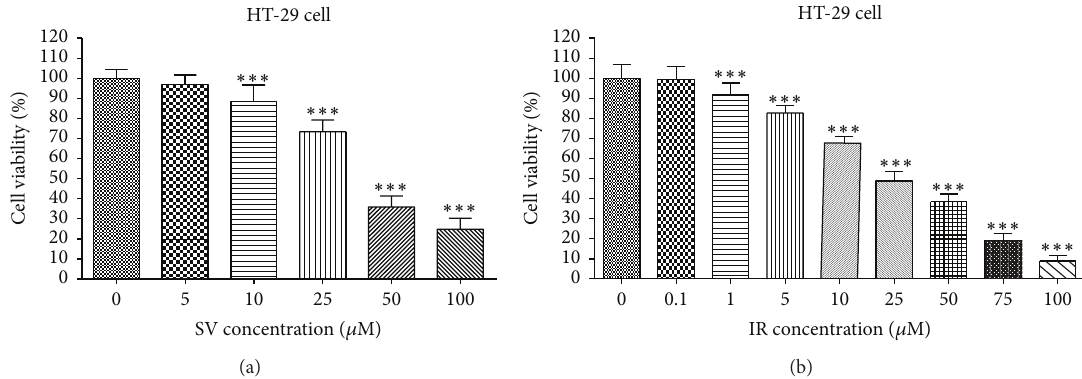
Figure 1: Effect of simvastatin or irinotecan alone on cell viability in HT-29 cell. Human colon cancer cells HT-29 were treated with serial concentrations of simvastatin (SV) and irinotecan (IR) for 48h in 96-well plates, and cell viability was measured by MTT assay, respectively (a, b). The data are expressed as the means ± SD from three independent experiments. ∗∗∗ 𝑃 < 0.001 , compared to untreated control cells. HT-29 (irinotecan-resistant) cell